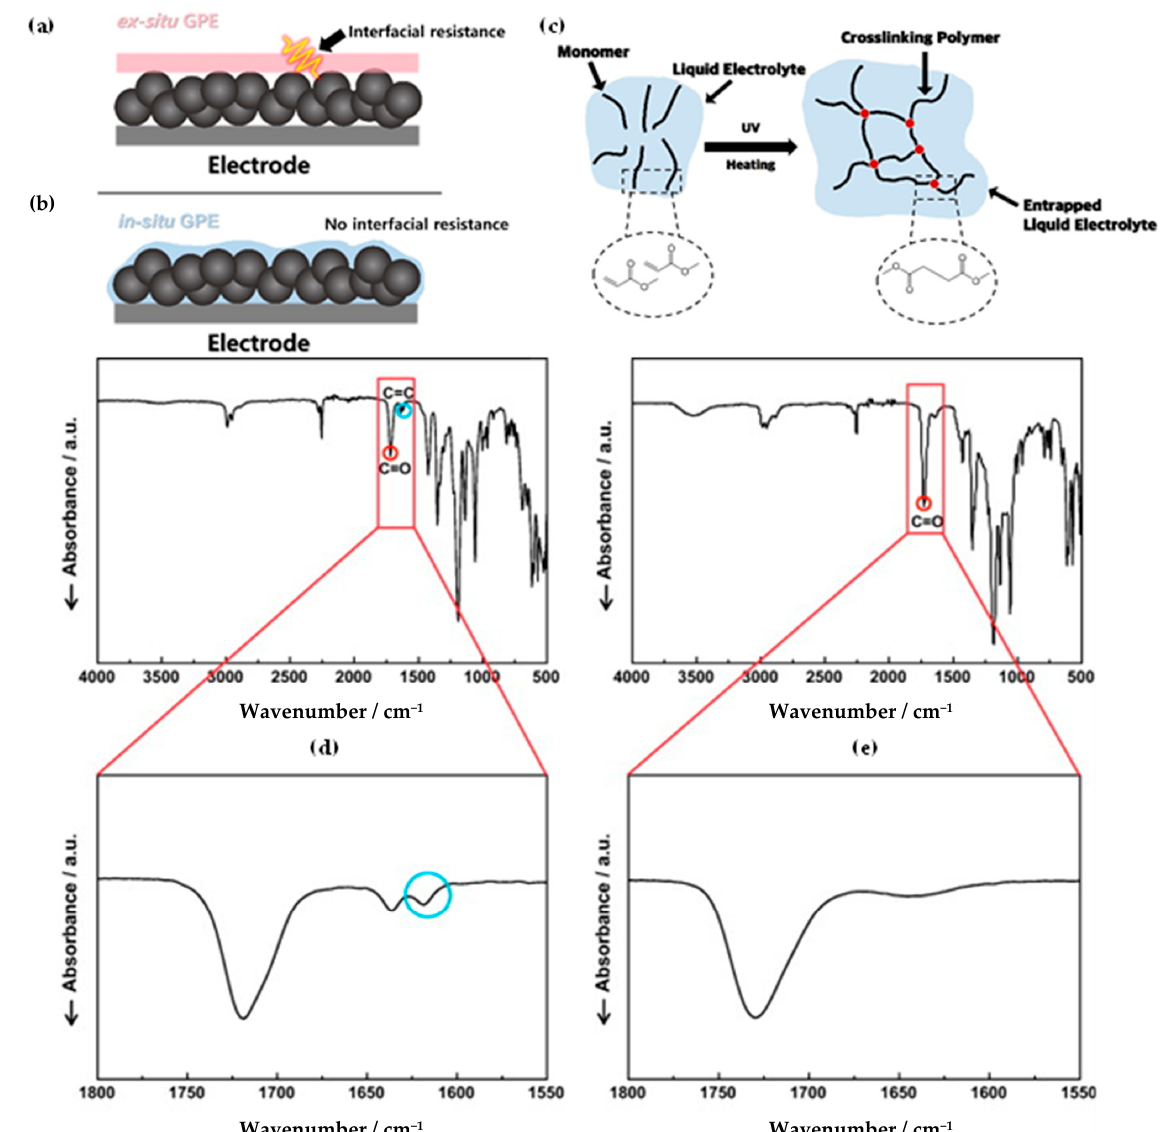
Figure 2. GPEs prepared by ( a ) ex situ and ( b ) in situ; ( c ) in situ polymerization methods; FT-IR spectra of acrylic C=C double bond ( d ) before initiation and ( e ) after initiation. ( d ) Reprinted/adapted with permission from Ref. [78]. Copyright ® 2011, Elsevier B. V.